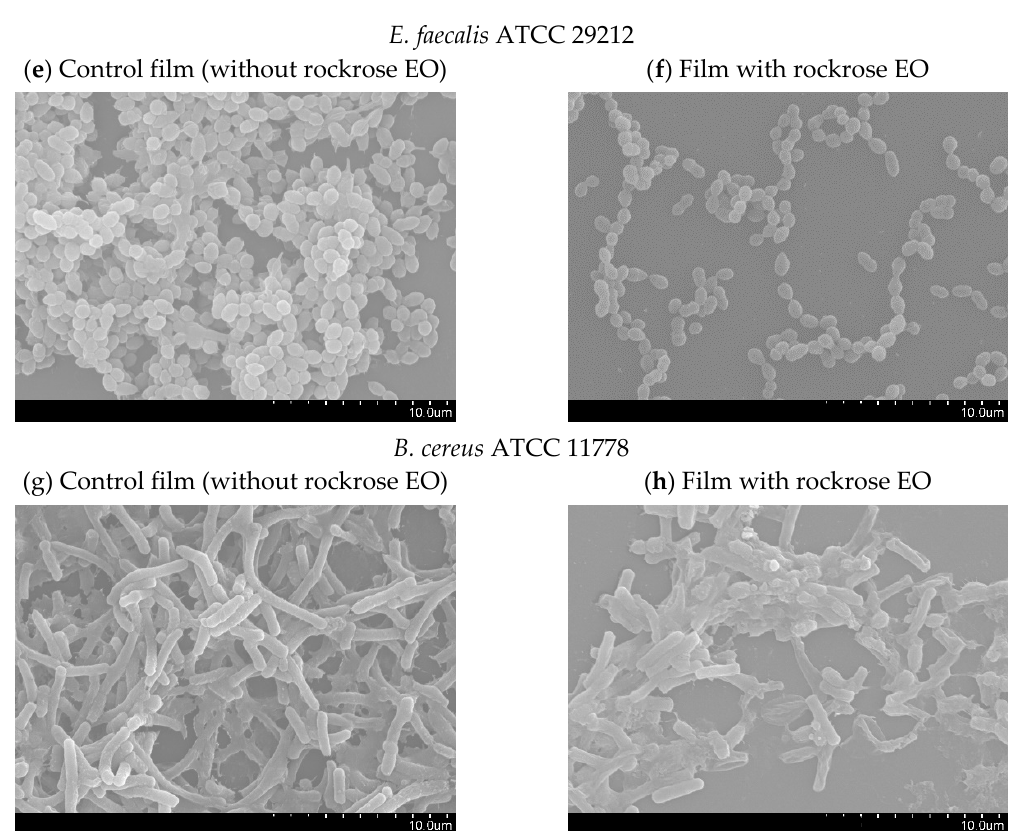
Figure 4. SEM micrographs ( a )–( h ) of the Gram-positive bacteria biofilms formed directly on the surface of the pullulan-based films (Magnification: 5000×).